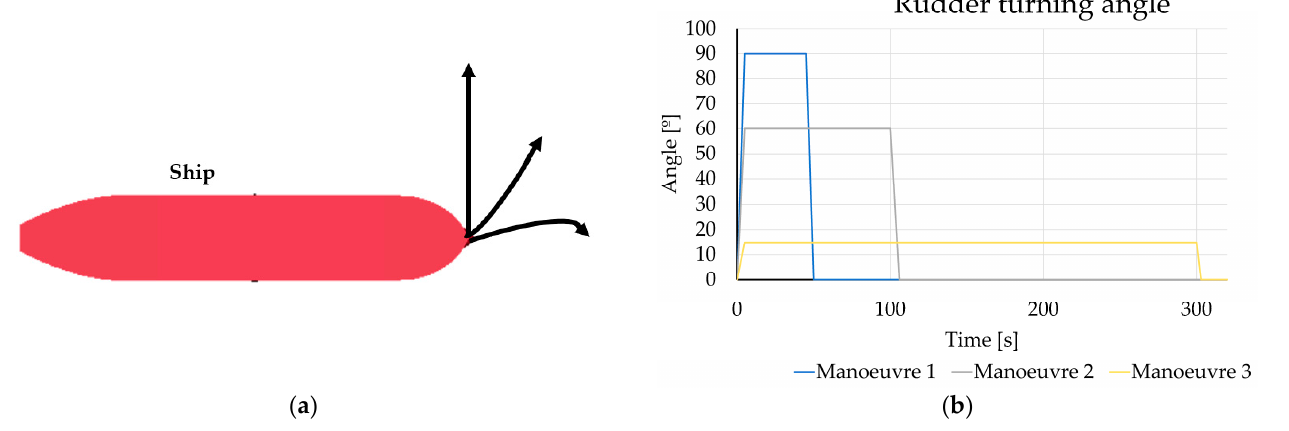
Figure 13. Ship model: ( a ) Manoeuvres, ( b ) Rudder turning angle.